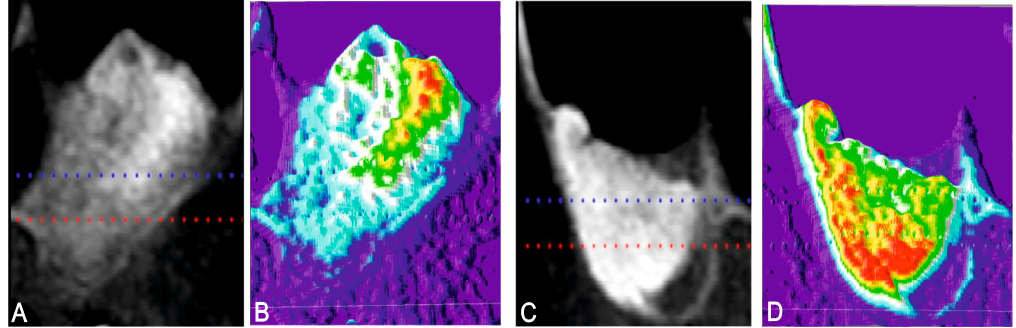
Figure 3. X-ray of the implant site six months after xenograft materials implantation and the corresponding color bone density ( A , B ) the PBM material and ( C , D ) the BPM material.